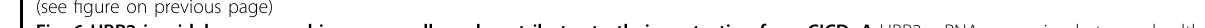
Fig. 6 UBR2 is widely expressed in cancer cells and contributes to their protection from CICD. A UBR2 mRNA expression between healthy tissue (breast) and cancer tissue (invasive breast carcinoma). Data were obtained from the Oncomine database. B Immunoblots of UBR2 expression in the indicated breast cancer cell lines. Actin was used as a loading control. C MDA-MB-231 cells were transfected with the indicated siRNA and treated with Actinomycin D alone (1 μ M) as an « apoptosis » stimulus or in combination with the pan-caspase inhibitor qVD-OPH (20 μ M) as a « CICD » stimulus for 24 h. Cell death was measured by fl ow cytometry using a DAPI staining. Data are expressed as mean ± s.d ( n = 3). D Real-time quanti fi cation of MDA-MB-231 cells transfected with the indicated siRNA and stained for Propidium Iodide in response to treatment with UV (40 J/m 2 ) in combination with qVD-OPH (20 μ M) as a CICD stimulus, using the Incucyte ZOOM Live-Cell Imaging system. NT = not treated. E DRUGSURV Database shows that High levels of UBR2 mRNA ( n = 91) predicts a poor survival compared to low levels ( n = 90) in patients suffering from breast cancer. F graphic summary of our work, see text for details. ** p < 0.01, *** p < 0.001 according to a two-way ANOVA. N.S: non-signi fi cant. Data are expressed as mean ± s.d ( n = 3) immunoblots and incucyte data are representative of 3 individual